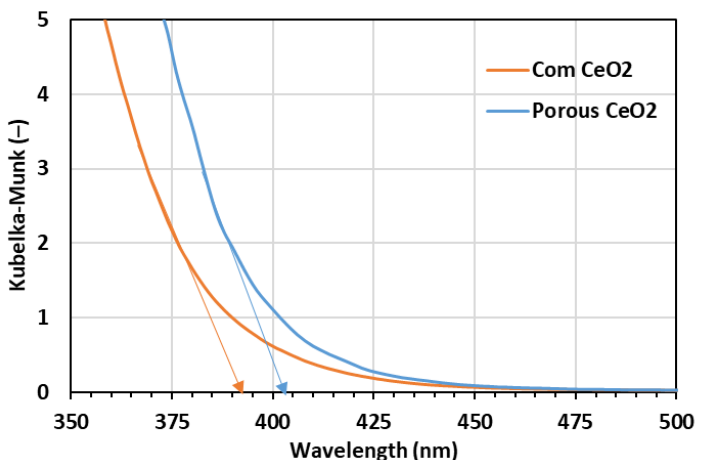
Figure 5. The adsorption behavior of the compared ceria samples expressed as Kubelka-Munk as a function of the measured wavelength (nm). Bandgap calculation was 3.12 and 3.01 eV for the com- mercial and porous ceria, respectively.